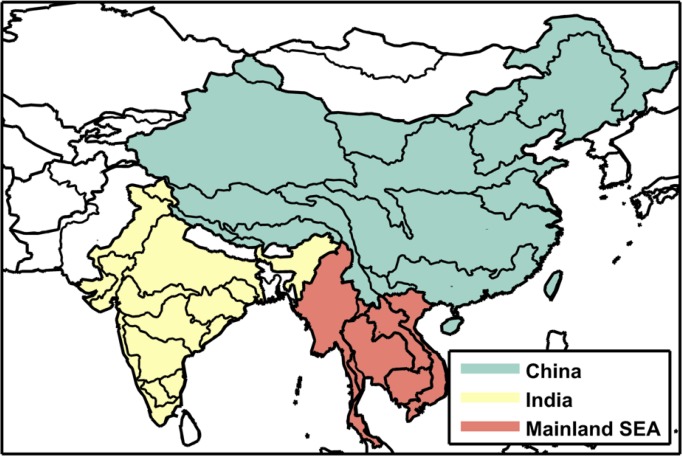
Map of major political regions showing the aggregate frequency distributions of water stress.